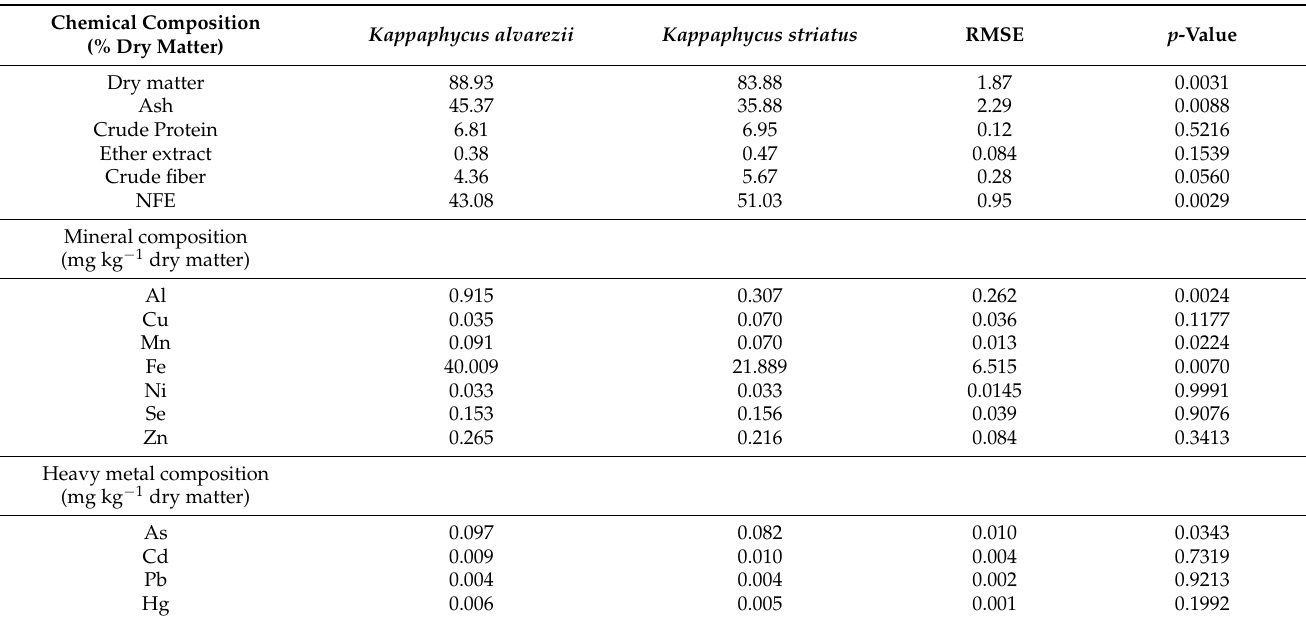
Table 1. Chemical characteristics, mineral and heavy metal composition of dried K. alvarezii and K. striatus